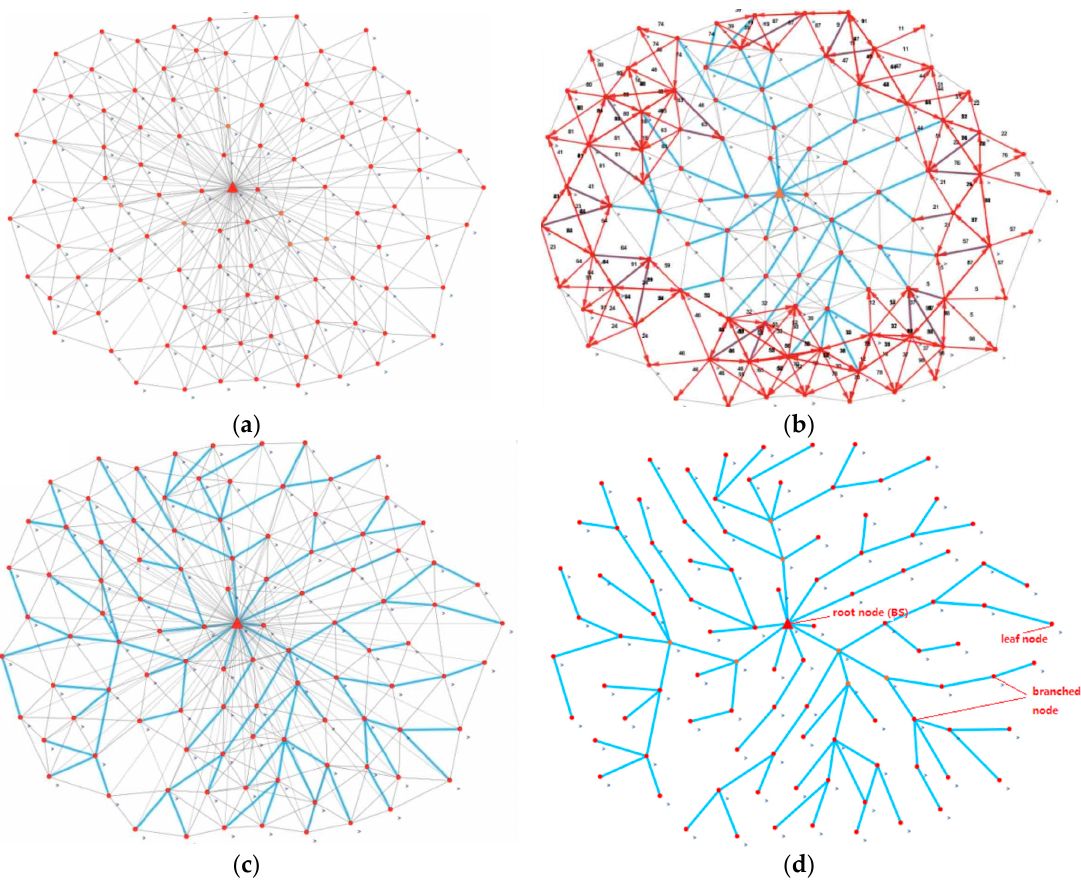
Figure 3. Flooding tree algorithm phases to build a tree type sub-network. The flooding phase enables one to create a unique and fast path between all nodes in the network. ( a ) Network initialization; ( b ) Running flooding tree algorithm; ( c ) Build tree type network; ( d ) Network finished.